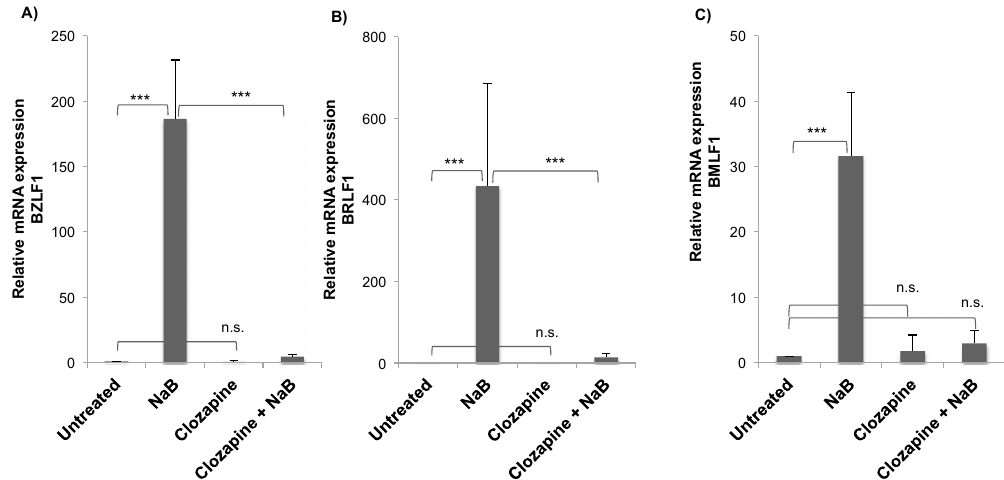
Figure 2. Clozapine inhibited the induction of Epstein–Barr virus (EBV) lytic gene expression. Expression of each gene, ( A ) BZLF1, ( B ) BRLF1, ( C ) BMLF1, was measured by RT-qPCR in untreated HH514-16 cells compared to treatment for 24 h with NaB (3 mM), clozapine (50 µ M), or the combination of NaB and clozapine. Values are the average fold induction compared to the untreated control of four or more biological replicates. Error bars show the standard deviation. Di ff erences with a p -value < 0.001 are denoted with ***, p -value < 0.01 with **, and not significantly di ff erent ( p -value > 0.05) with n.s.